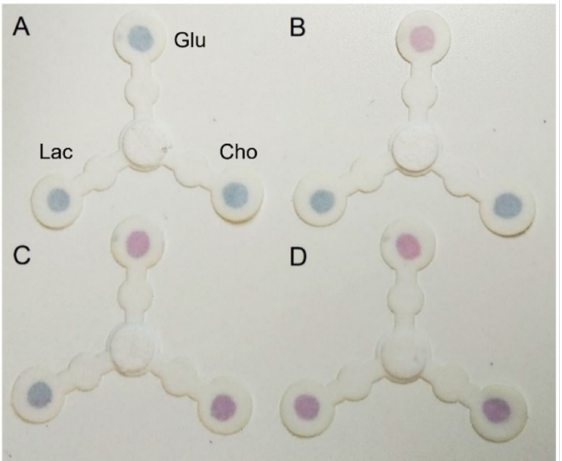
Figure 5. Photographs of four devices at the end of the reaction (10 min) treated respectively with ( A ) native saliva, ( B ) saliva spiked with one target biomarker (14 µ M glucose (Glu)), ( C ) saliva spiked with two targets (14 µ M glucose + 5.2 µ M cholesterol (Cho)), and ( D ) saliva spiked with all the targets (14 µ M glucose + 5.2 µ M cholesterol + 2 mM lactate